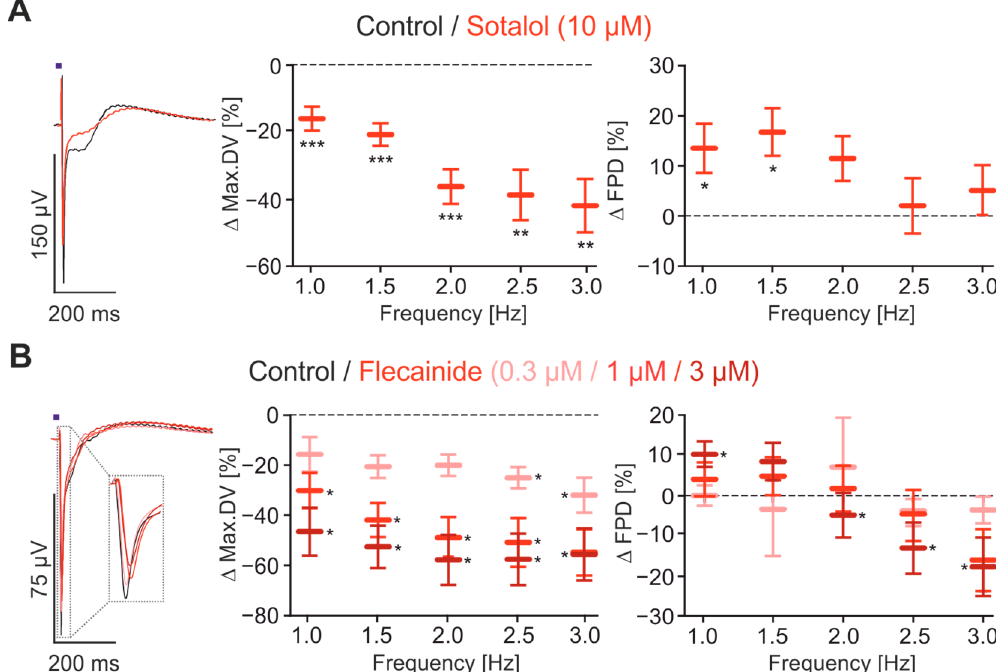
Figure 5. Analysis of drug effects on FP. ( A , B ) Overlay of representative FP optical paced at 1 Hz (left) before (black) and after drug application (red), and statistical analysis of the relative changes of max.DV (middle) and FPD (right) at the frequencies 1–3 Hz. ( A ) Effects of 10 μ M Sotalol ( n = 13–17); ( B ) effects of 0.3, 1 and 3 μ M Flecainide ( n = 11–12). * p < 0.05, ** p < 0.01, *** p < 0.001.